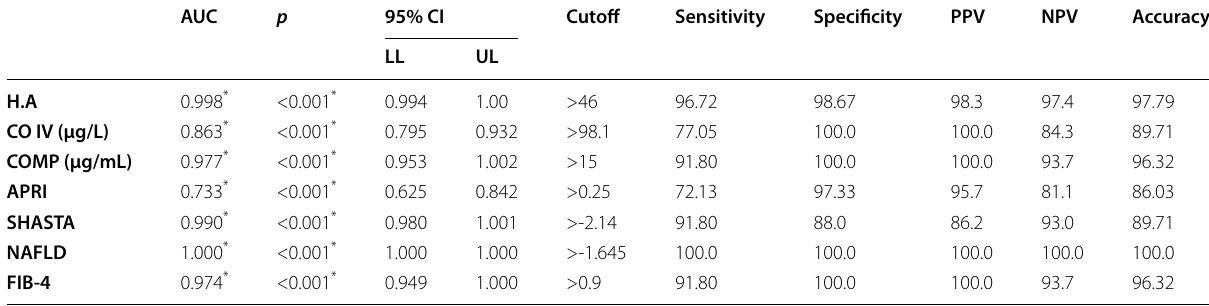
Table 1 Presentation of sensitivity and specificity and accuracy of serum biomarkers levels and fibrosis scoring systems to discriminate liver fibrosis from control curve in HCV patients AUC